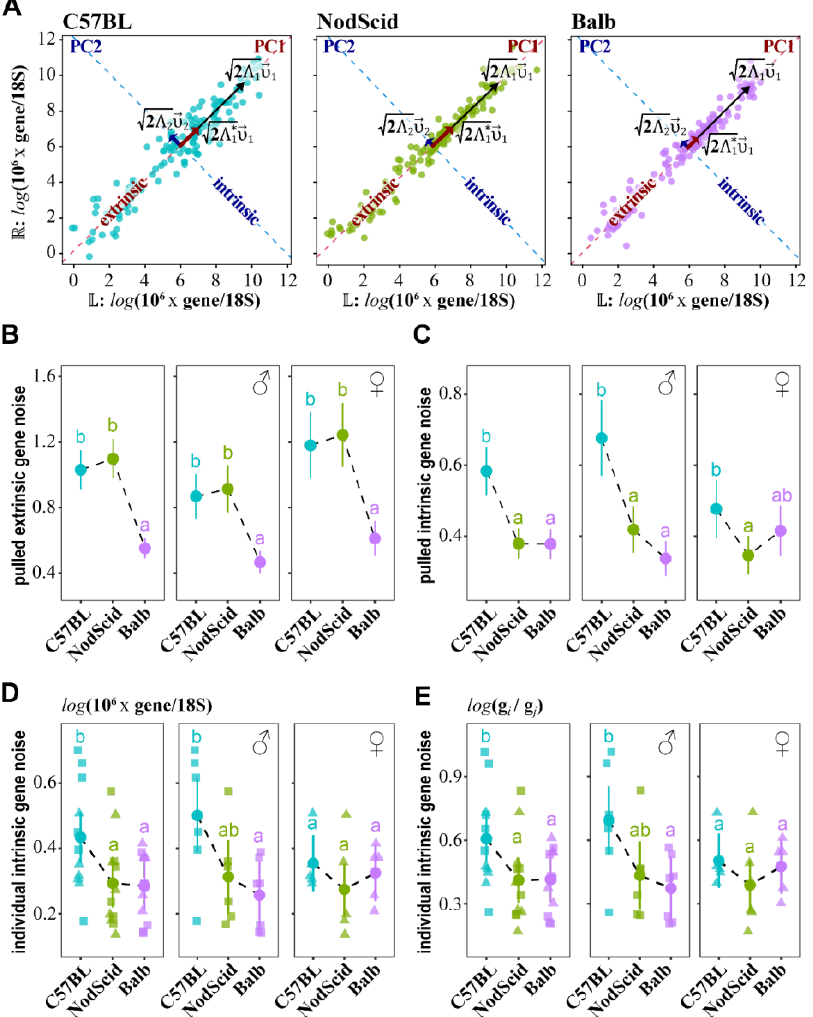
Figure 2. The impact of mother – fetus MHC-mediated immunogenic cross- talk on the “extrin- sic”/“intrinsic” gene noise in C57BL/6J embryos. ( A ) PCA decomposition of 18S rRNA-normalized- log-transformed gene expressions in the left ( 𝕃 ) and right ( ℝ ) forelimbs of C57BL/6J embryos on day 16.5 of gestation. The embryos were carried by C57BL/6J ( n = 11 embryos carried by m = 8 females), NOD-SCID ( n = 12, m = 8), and BALB/c ( n = 12, m = 7) surrogate mothers. The PC1 and PC2 axis and eigenvectors √2Λ 1 υ⃗⃗ 1 , √2Λ 2 υ⃗⃗ 2 , and √2Λ 1∗ υ⃗⃗ 1 are indicated, where Λ 1∗ corresponds to the 1 st eigen- value of a gene-wise, mean-centered left/right expression matrix. ( B,C ) Mother – embryo interaction has an impact on pulled “extrinsic” ( 𝜂 𝑒𝑥𝑡. ≈ √2Λ 1∗ ) ( B ) and “intrinsic” ( 𝜂 𝑖𝑛𝑡. ≈ √2Λ 2 ) (C) gene ex- pression noise estimated group-wise for C57BL/6J embryos developing in C57BL/6J, NOD-SCID, and BALB/c surrogate mothers. The estimates were determined for either each mother ’s genotype or separately for each mother ’ s genotype and fetus sex: C57BL/6J ( n ♂ = 6, n ♀ = 5), NOD SCID ( n ♂ = 6, n ♀ = 6), and BALB/c ( n ♂ = 5, n ♀ = 7). Circles correspond to GAMLSS model-estimated coefficients: ( B ) √2𝜎̂ 𝑃𝐶1 ≈ 𝜂̂ 𝑒𝑥𝑡. and ( C ) √2𝜎̂ 𝑃𝐶2 ≈ 𝜂̂ 𝑖𝑛𝑡. , and whiskers denote 95% confidence intervals. Letters indicate significant between-group differences at FDR < 0.05 for multiple comparisons of the model- estimated coefficients by Wald tests. ( D , E ) Estimations of pulled “intrinsic” gene noise ( √2Λ 2 ≈ √2𝜎 𝕌−𝕍 ≈ 𝜂 𝑖𝑛𝑡. , Equation (14)) for each embryo using left ( 𝕌 )/right ( 𝕍 ) 18S rRNA-normalized gene expressions ( D ) or ΔCt s of all pair-wise gene combinations ( E ). Squares ( ♂ ) and triangles ( ♀ ) indicate individual values of pulled “intrinsic” gene noise, circles — mean values for each surrogate mother group, and whiskers — 95% confidence intervals. Letters indicate multiple t-test comparisons with significant differences at FDR < 0.05.